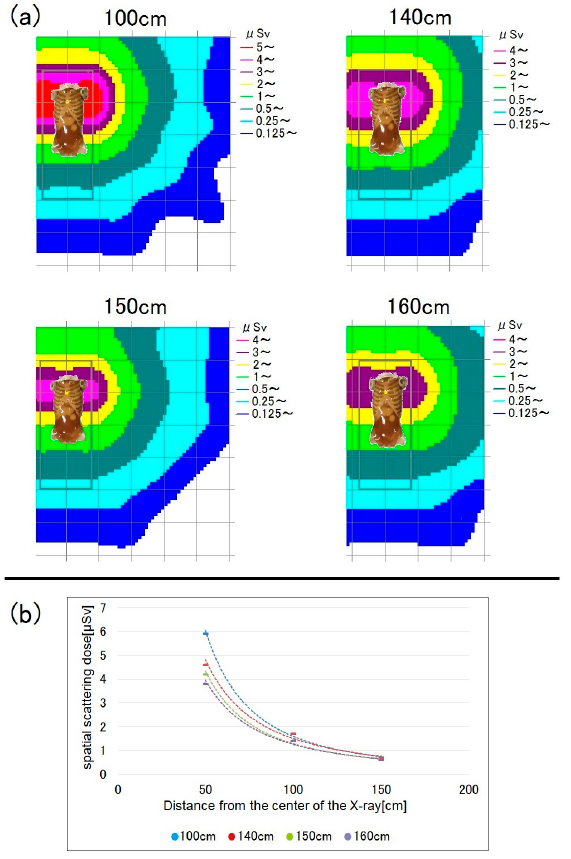
Figure 5. Spatial scattered radiation dose by measurement height (100, 140, 150, and 160 cm) at a bed height of 50 cm. Lower measurement points were associated with higher spatial doses. ( a ) Dose-distribution map and ( b ) graph showing the spatial doses.